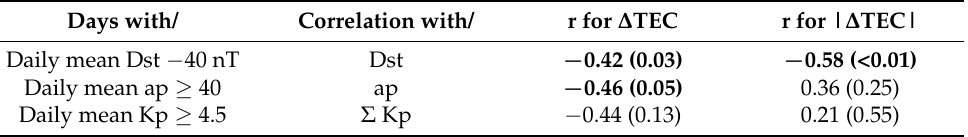
Table 11. Correlation coefficients r between ∆ TEC and SW parameters observed during non-quiet days: days with larger number of flares or geomagnetic disturbances; p values are in parentheses. Statistically significant (95%) r are in